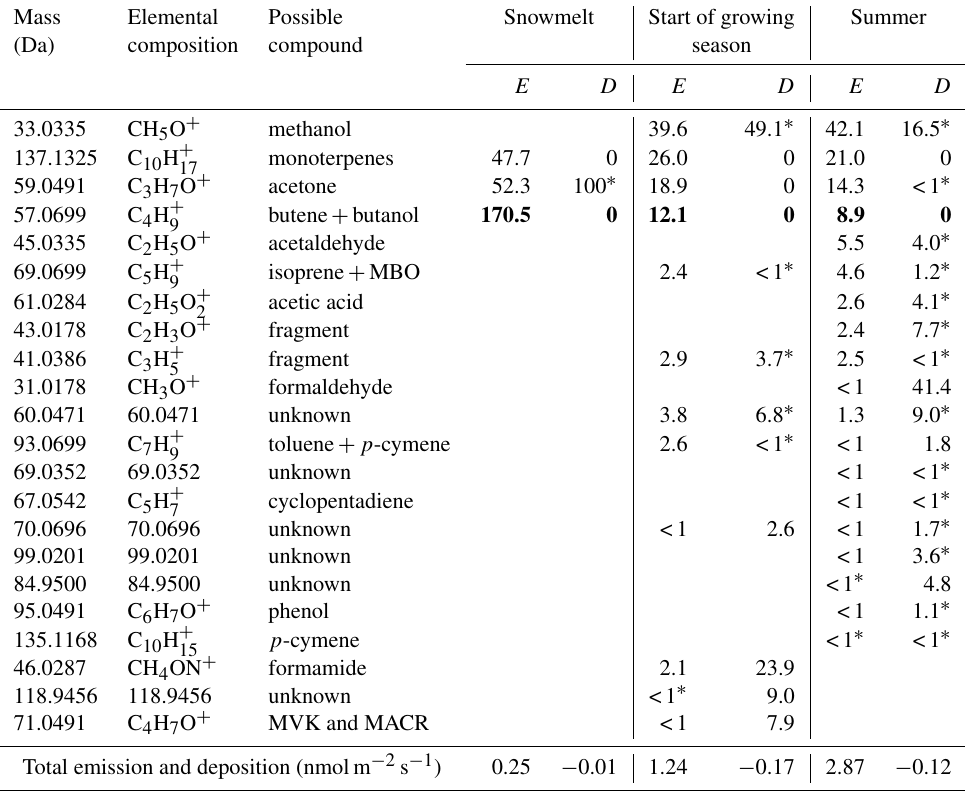
Table 1. The exchange of the different compounds in during the measurements in April, May and June. All the presented emission ( E ) and deposition ( D ) values are in percentages in relation to the total emission or deposition of the month (stated in the last line). Emissions of butene + butanol are in bold as they are anthropogenic (Sect. 3.4) and, therefore, not included in the total exchange.